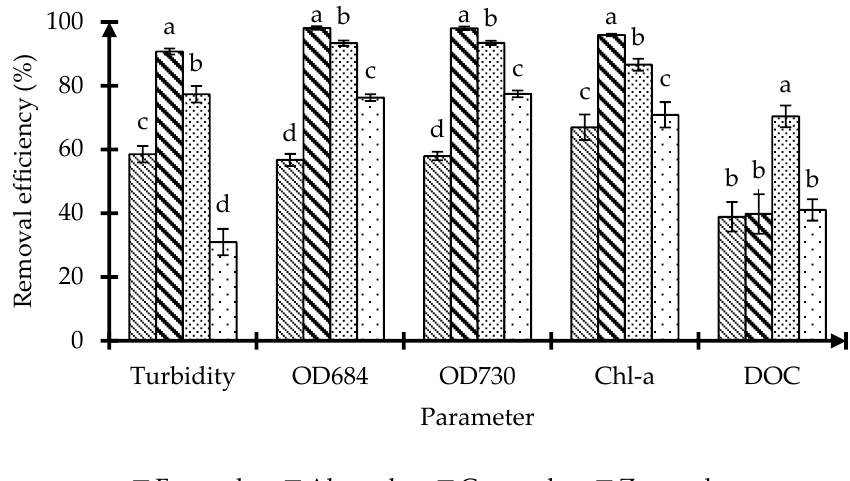
Figure 6. Removal efficiency as a function of turbidity, optical density, Chl-a concentration, and dissolved organic carbon concentration for different anode materials. Error bars represent the standard deviation ( n = 3). Different superscripts in bars for each parameter indicate a significant difference at 0.05 significant level for different anodes.